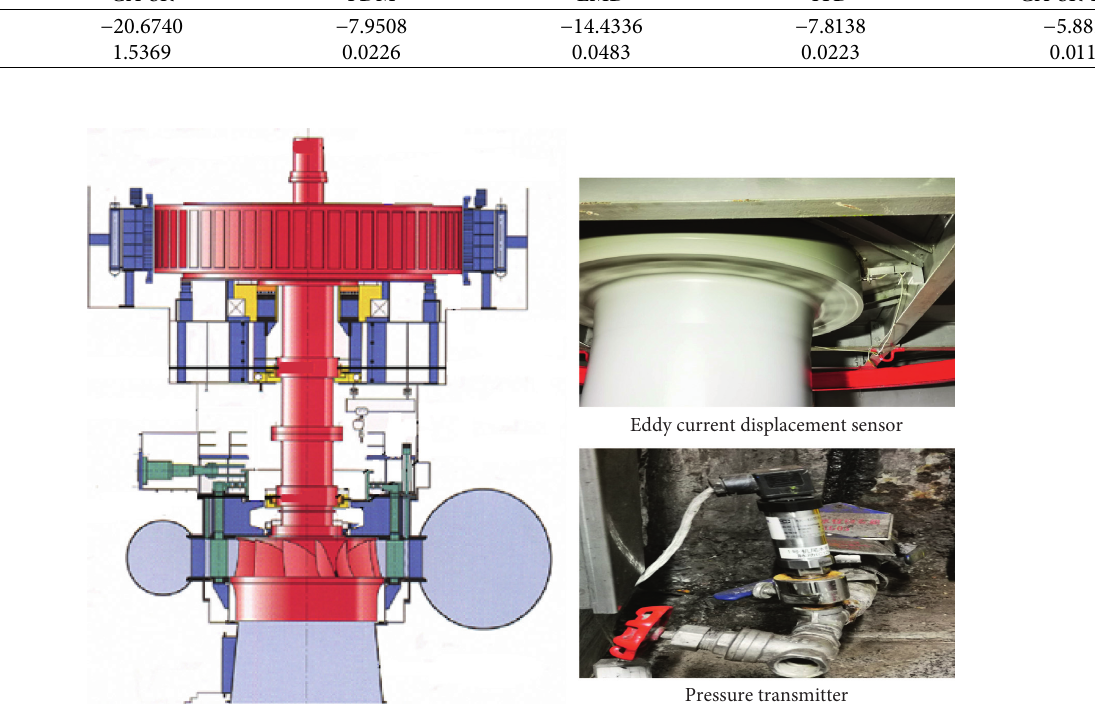
Figure 3: Schematic diagram of the unit structure and sensor